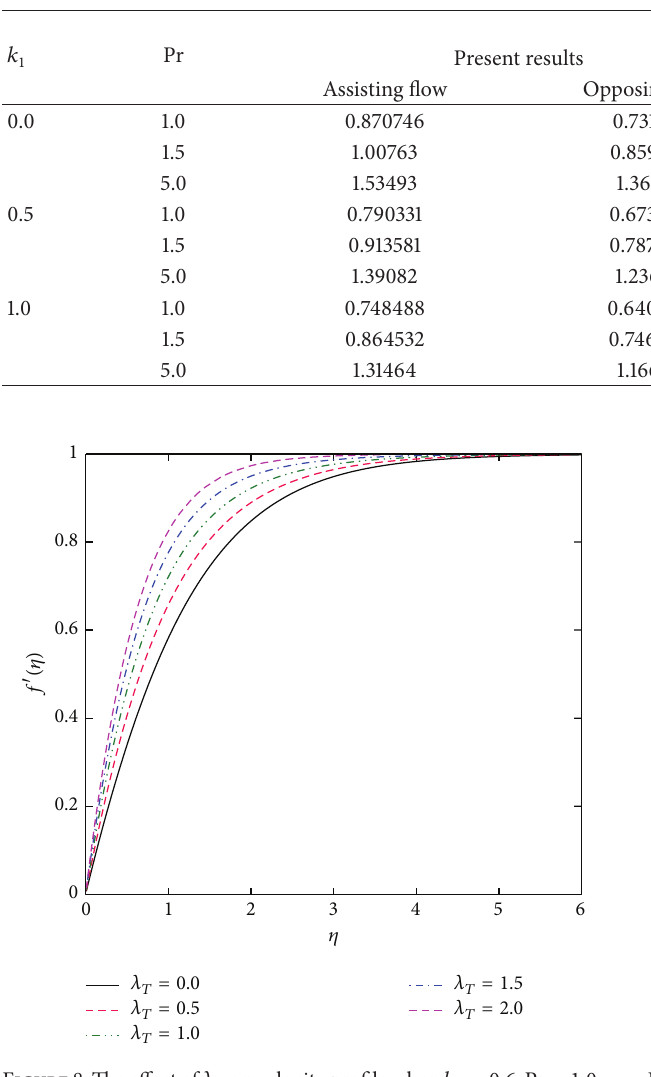
Table 4: Comparison of −𝜃 󸀠 (0) for various values of 𝑘 1 and Pr when 𝑚 = 1.0 and 𝜆 𝑇 = 1.0 .